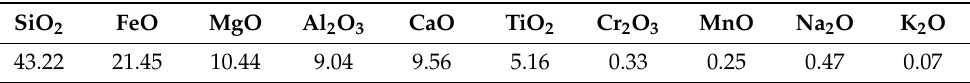
Table 1. Apollo #12022 composition used in the calculation of saturated vapor pressures, data from Snyder et. al. [23]. Values adjusted to 100% omitting trace